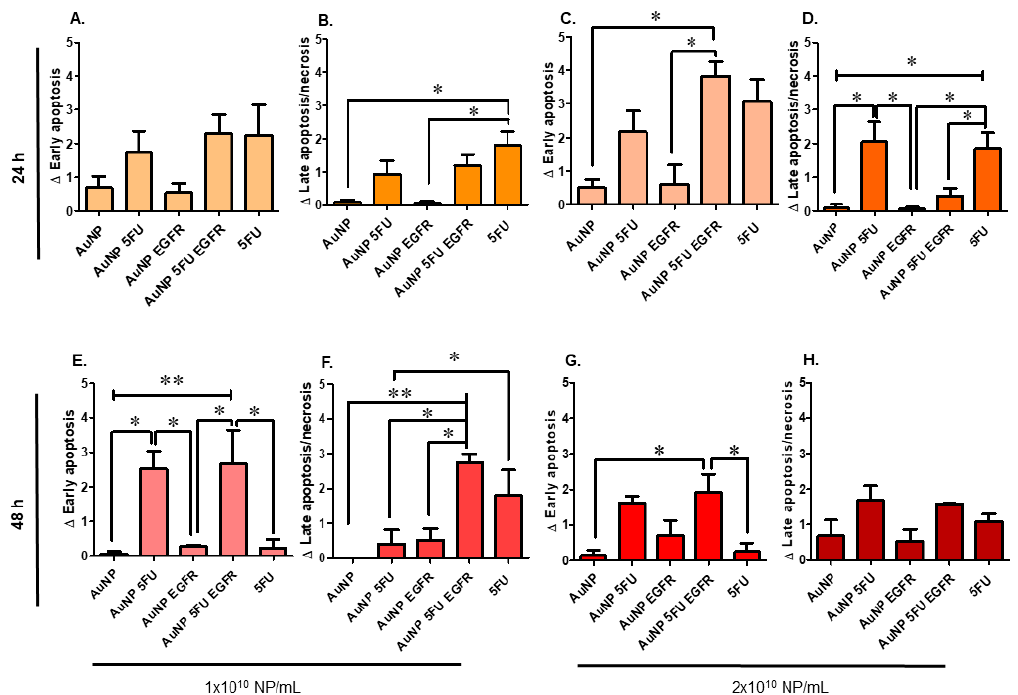
Figure 3. Cytotoxicity of the different concentrations of composites on HT-29 cells treated for 24 and 48 h. In the upper left, show the treatments with 1 × 10 10 nanoparticles/mL in 24 h: ( A ). Early apoptosis (annexin V + ); ( B ). late apoptosis/necrosis (annexin V + and 7AAD + ) and in the upper right, show the treatments with 2 × 10 10 nanoparticles/mL in 24 h: ( C ). early apoptosis; ( D ). late apoptosis/necrosis. In the lower left, show the treatments with 1 × 10 10 nanoparticles/mL in 24 h: ( E ). early apoptosis; ( F ). late apoptosis/necrosis and in the lower right, show the treatments with 2 × 10 10 nanoparticles/mL in 24 h: ( G ). early apoptosis and ( H ). late apoptosis/necrosis. Statistical analysis was performed by one-way ANOVA with Tukey post-test, with significance of * p < 0.05 and ** p < 0.001.